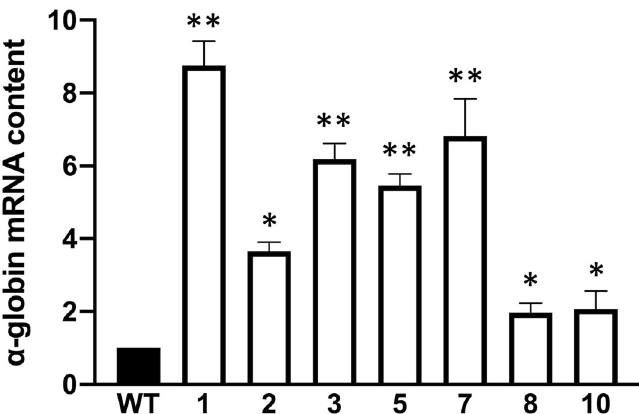
Figure 2. Summary showing α-globin mRNA content in obtained clones versus K562 wild-type cells (mean ± SD; N = 3). p < 0.05 (*), p < 0.01 (**).